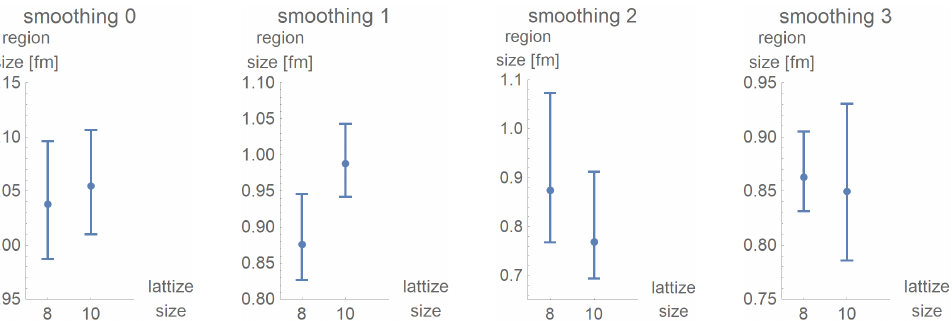
Figure 11. After one cooling step, the extension of homogeneous regions is not significantly bigger than without cooling. For further analysis, the data of smoothing 2 will be